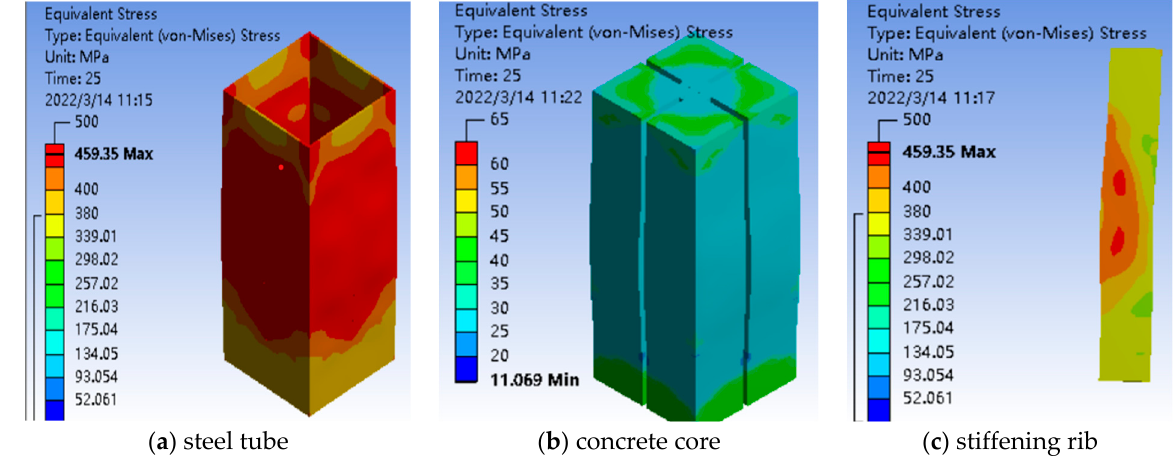
Processes 2023 , 11 , 769